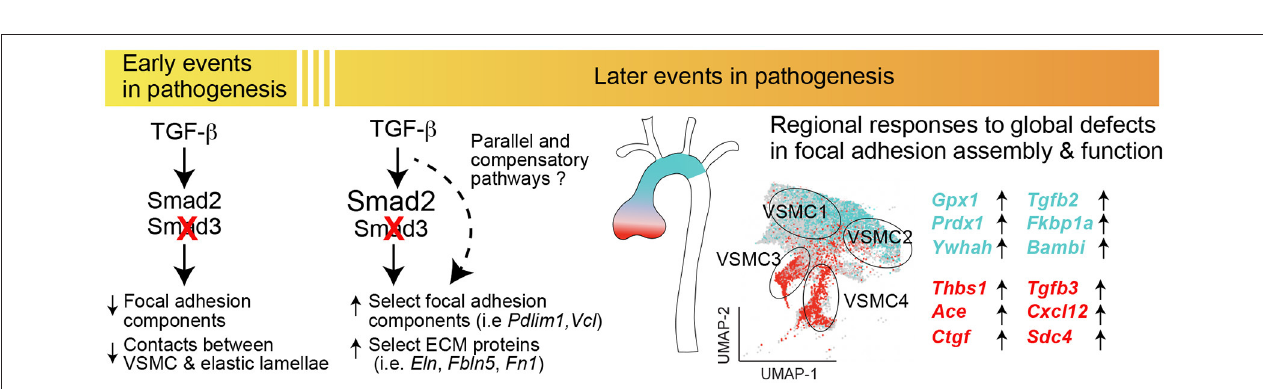
FIGURE 9 | coding for proteins in the network. Size of the node indicates the percent of cells in the subcluster that express a given transcript. Color bar indicates the gradient of cells populating VSMC subsets in the aortic root and proximal ascending aorta (red) and distal ascending aorta and arch (cyan), with VSMC1 cells being most enriched in the distal ascending aorta and arch and VSMC4 cells being most enriched in the aortic root and proximal ascending aorta. (B) Dot plots of protein and non-protein coding transcripts that show VSMC subset-specific behavior. The intensity of the dot’s color corresponds to a scaled average expression of each transcript while the size of the dot indicates the percentage of cells in each cluster that express that transcript. Vertical bar indicates the gradient of cells populating VSMC subsets in the aortic root and proximal ascending aorta (red) and distal ascending aorta and arch (cyan).